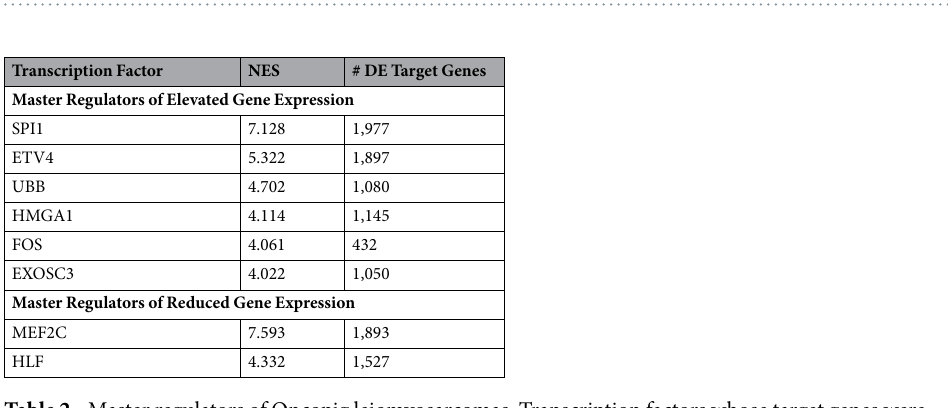
Table 2. Master regulators of Oncopig leiomyosarcomas. Transcription factors whose target genes were enriched (normalized enrichment score (NES) > 4) among the differentially expressed (DE) genes displaying either elevated or reduced